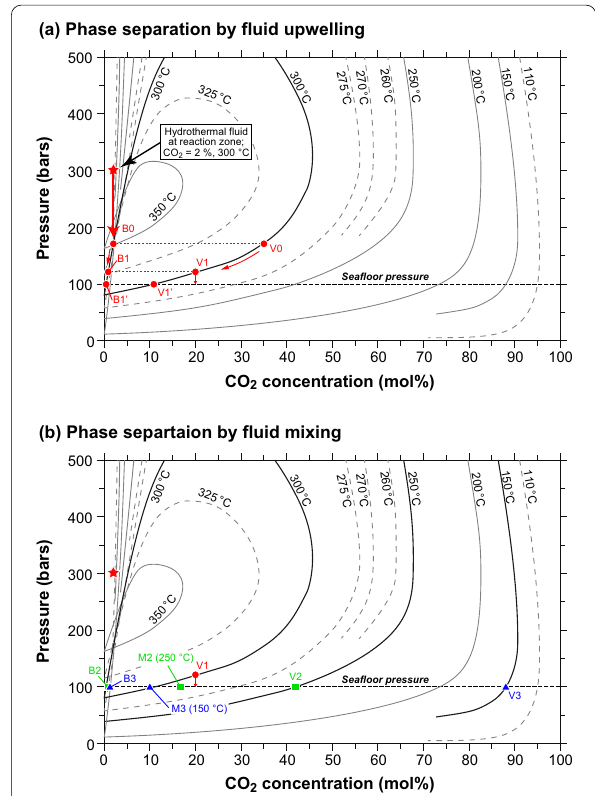
Fig. 2 Evolution of fluid compositions associated with phase separation caused by a depressurization due to fluid upwelling and b temperature decrease due to fluid mixing (see text for details). Isotherms are enlarged from those in Fig. 1 (Takenouchi and Kennedy 1964). B, V, and M stand for brine, vapor, and mixed phases,